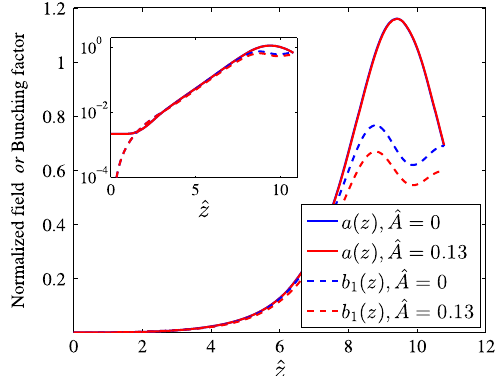
FIG. 1. The total normalized field amplitude a and bunching factor b 1 along the undulator for various energy modulation ˆ A amplitudes . The modulation wavelength is 8 μ m, correspond- ing to j Δ ν = 2 ρ j ≈ 0 . 16 The inset displays the same quantities on a logarithm